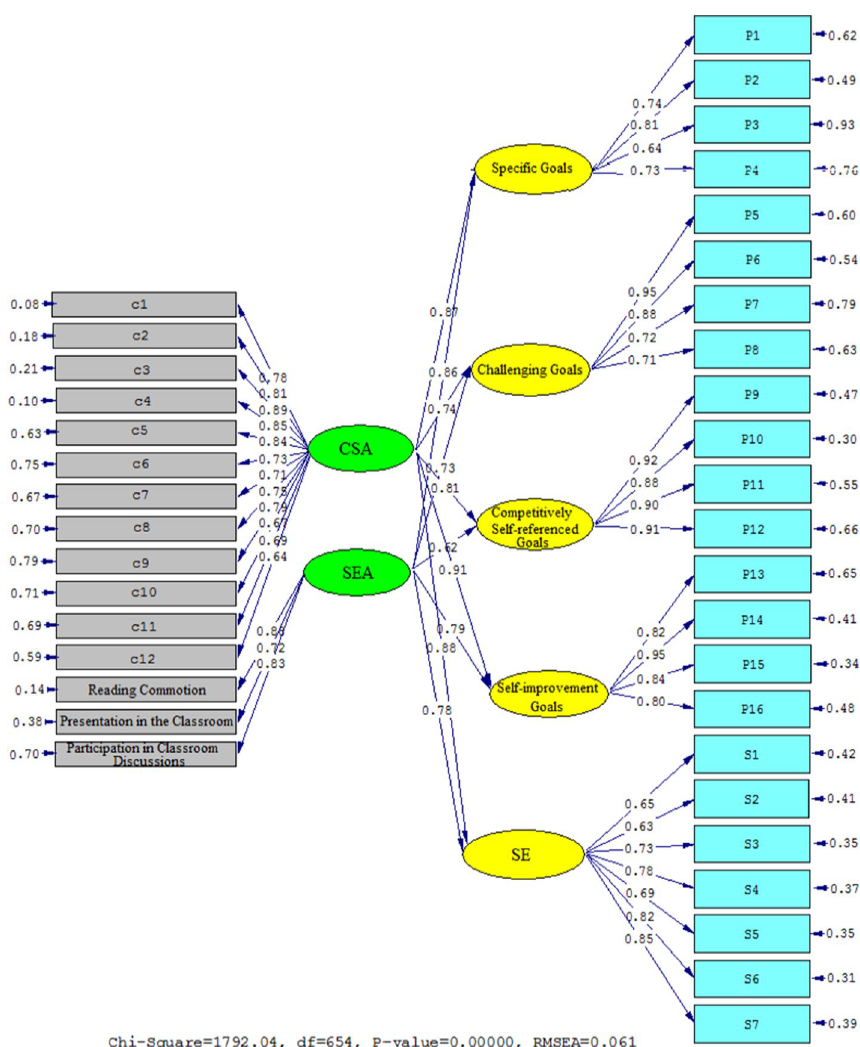
Fig. 4 Schematic representation of path coefficient values for the relationships between CSA, SEA, PBG components, and SE (model 2)